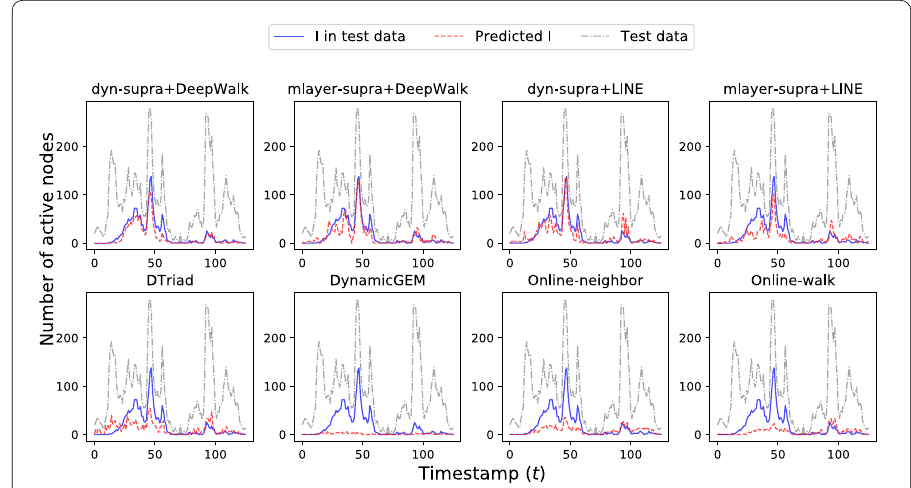
Figure 6 Example of predicted timelines of the number of active nodes in the infectious state, for the SFHH (conference) data set for the various methods. Here ( β , μ ) = (0.13,0.055) and ρ = 1. Line colors have the same meaning as in Fig. 5